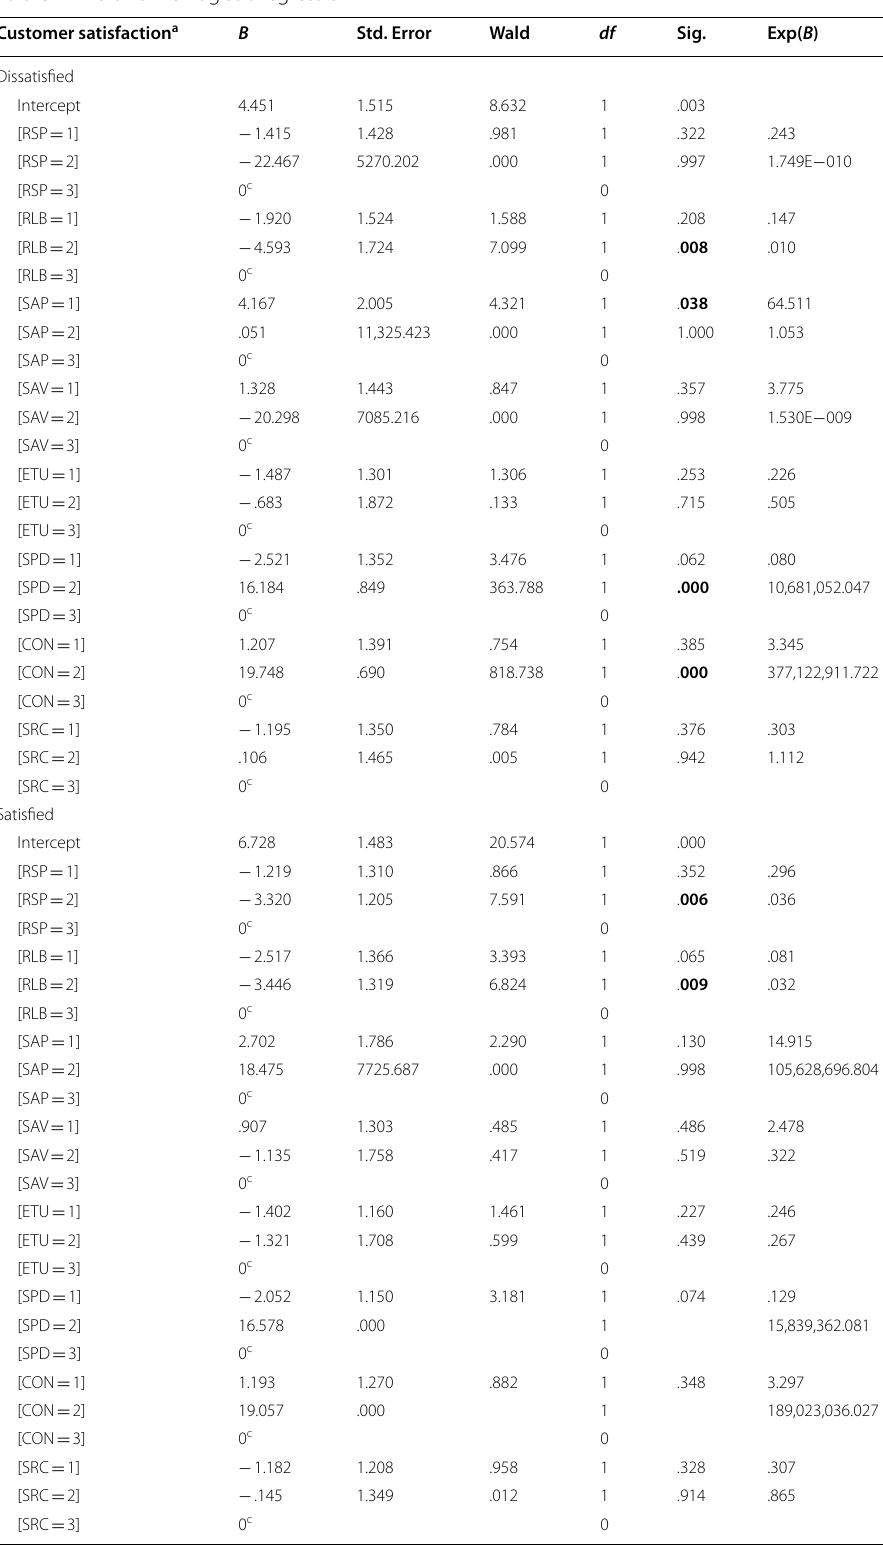
Table 7 Multinomial logistic regression Customer satisfaction